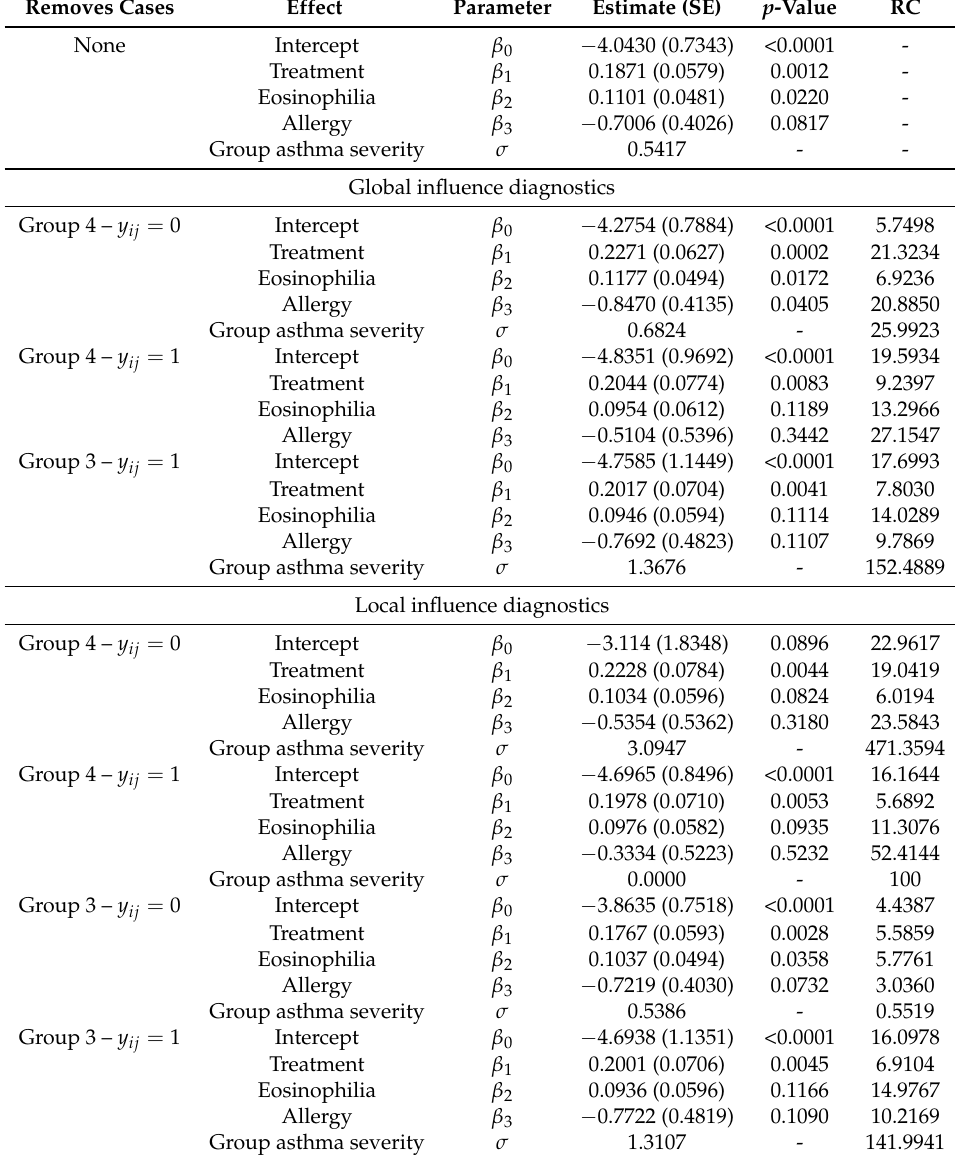
Table 8. Estimates (SE), p -values and RC under the indicated influence for the asthma data.